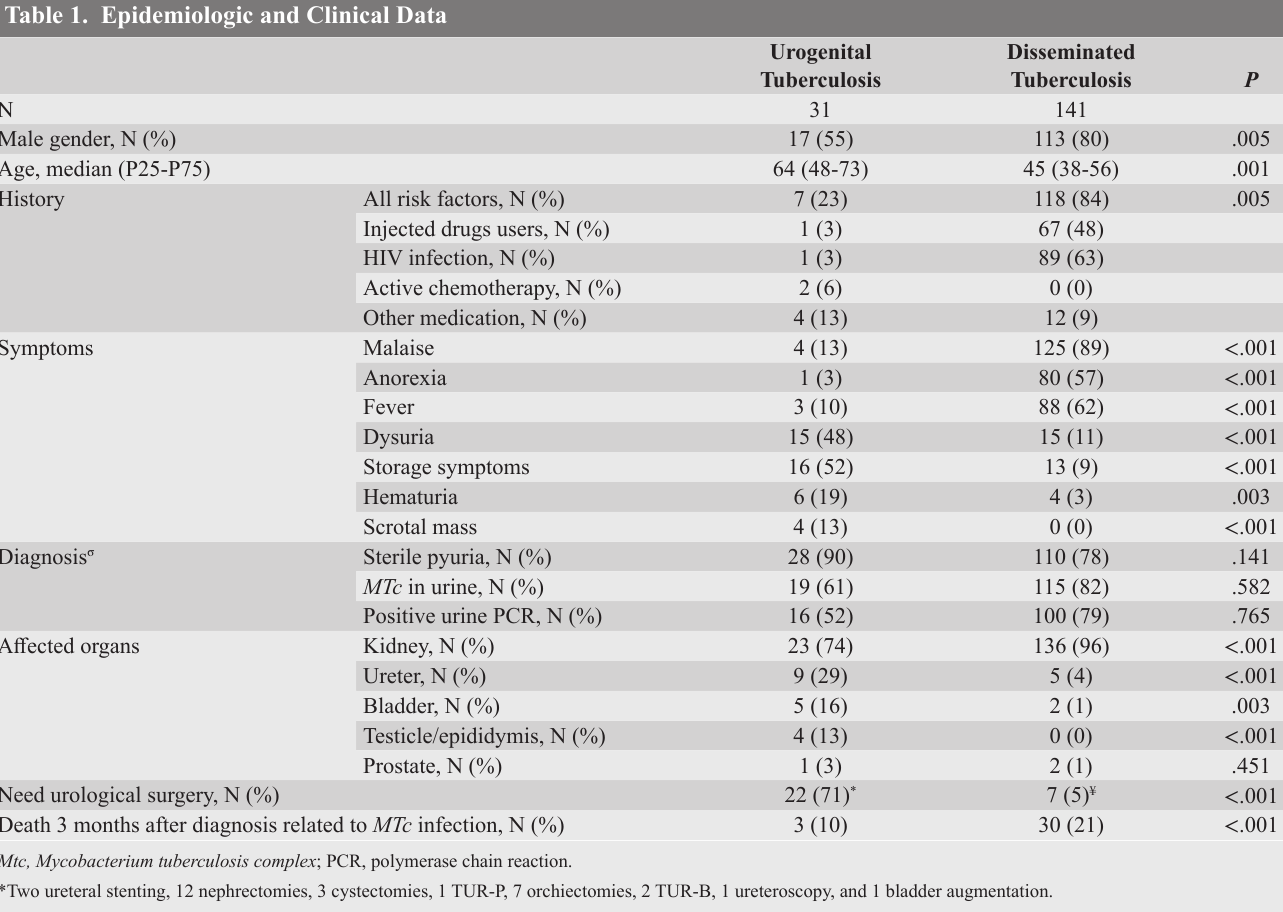
Table 1. Epidemiologic and Clinical